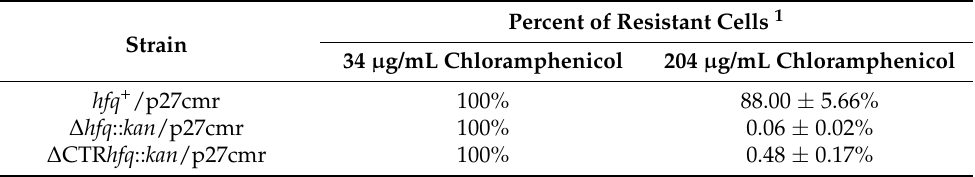
Table 4. Resistance of E. coli hfq + , ∆ hfq :: kan, and ∆ CTR hfq :: kan strains bearing the p27cmr plasmid to different concentrations of chloramphenicol.